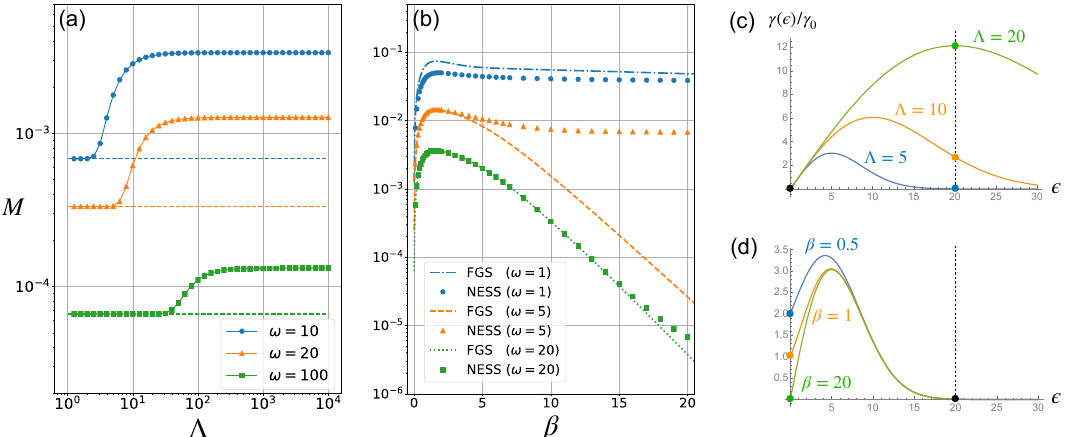
Figure 13: (a) Λ -dependence of total magnetization M . The circles, triangles, and squares denote the magnetization in the NESS for ω = 10,20, and 100, respectively. The dashed lines are the magnetization in the FGS for each ω . The other parameters are B = 1, β = 10, and L = 8. (b) β -dependence of total magnetization M . The circles, triangles, and squares denote the magnetization in the NESS for ω = 10,20, and 100, and the dash-dotted, dashed, and dotted lines are the magnetization in the FGS for corresponding ω . The other parameters are B = 1, Λ = 5, and L = 8. (c,d) γ ( ε ) /γ are plotted for (c) Λ = 5,10, and 20 with β = 10 and (d) β = 0.5,1, and 0 20 with Λ = 5. In γ ( ε ) , the y -intercept is 1 /β and the position of the peak is O ( Λ ) . Therefore, for example, | γ ( 0 ) /γ ( ω = 20 ) | becomes smaller for the larger Λ or the larger β